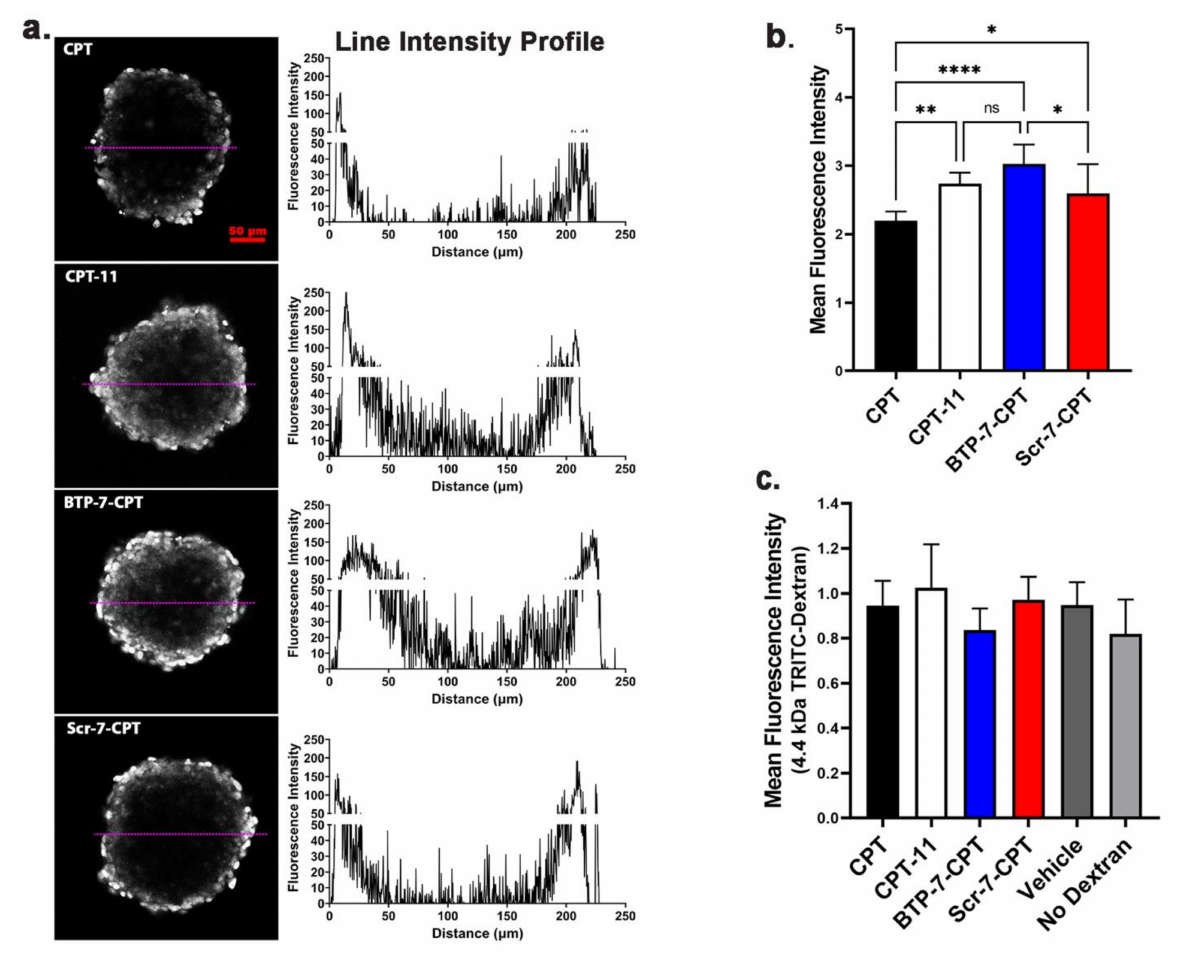
Figure 4. Conjugation of BTP-7 to CPT enhances permeability in human BBB organoids. ( a ) Fluo- rescence images showing the level of influx (penetration across the organoid surface) of BTP-7-CPT, Scr-7-CPT, CPT (camptothecin), and CPT-11 (irinotecan) (at 10 µ M) in BBB organoids. Scale bar: 50 µ m). Line profile (depicted by magenta line) showing the fluorescence (drug) level through the organoid. ( b ) Bar graph quantifying the mean fluorescence intensity of each drug conjugate, showing BTP-7-CPT had higher level of organoid influx compared to CPT and Scr-7-CPT ( n = 8 organoids, t = 3 h). ( c ) Co-incubation of BBB organoids with each drug conjugate (from ( b )) and 4.4 kDa TRITC-dextran (at 10 µ g/mL) did not affect the level of dextran influx (all data were not significantly different compared to the vehicle control), indicating that the presence of the drug conjugate did not alter the organoid’s surface integrity ( n = 6–8 organoids, t = 3 h). Statistical significance was determined using a one-way ANOVA and Tukey’s multiple comparisons test (* p < 0.05, ** p < 0.01, **** p <